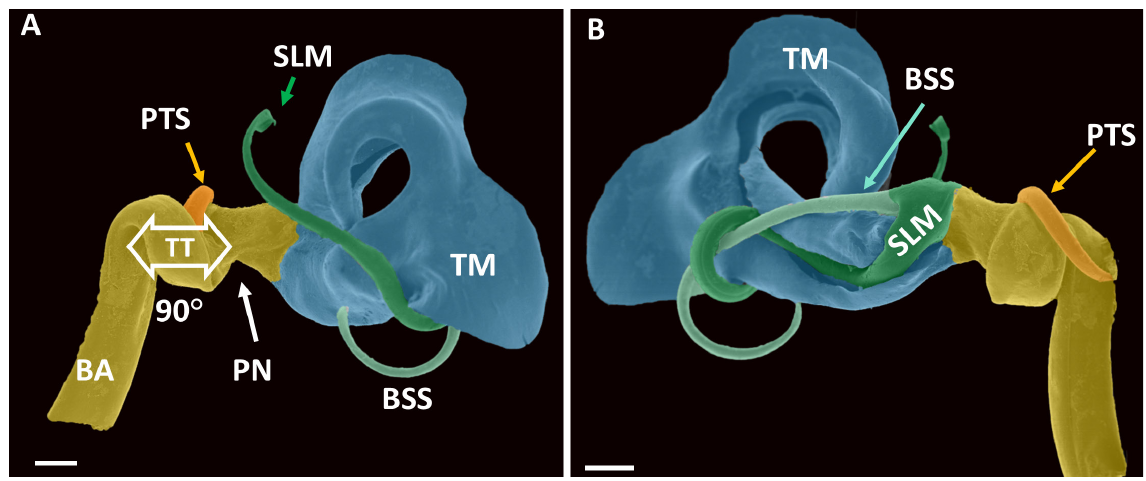
Fig. 6. Odontopygid gonopod terminology, telopodite, exemplified by Lamelloramus frederiksenae sp. nov., holotype, ♂ (NHMD 621744), left gonopod telopodite. A . Anterior view, “ 90° ” indicates arculus. The double-headed arrow indicates the torsotope. B . Posterior view. Abbreviations: BA = basomere (yellow); BSS = basal solenomeral spine (light green); PN = post-torsal narrowing; PTS = post-torsal spine (orange); SLM = solenomere (medium green); TM = telomere (blue); TT = torsotope. Scale bars = 0.2 mm. Cf. Fig.